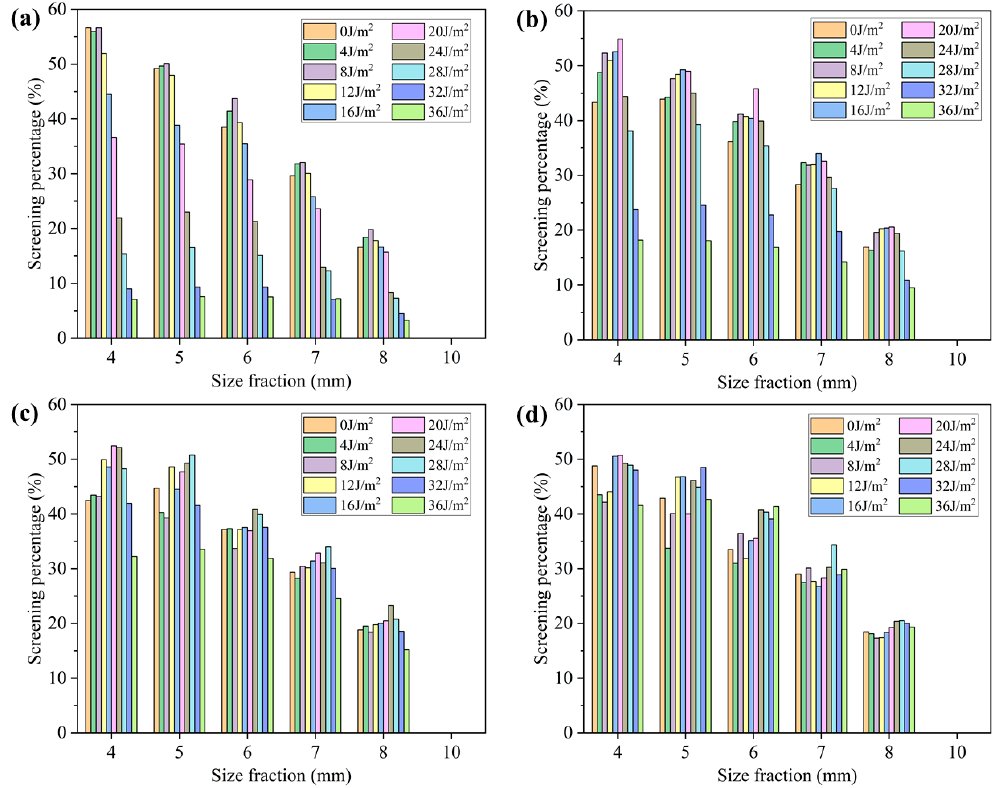
Figure 10. Comparison of the screening percentages of various size fractions in Sections 1 ( a ), 2 ( b ), 3 ( c ), and 4 ( d ) of VFFS with different surface energy levels.